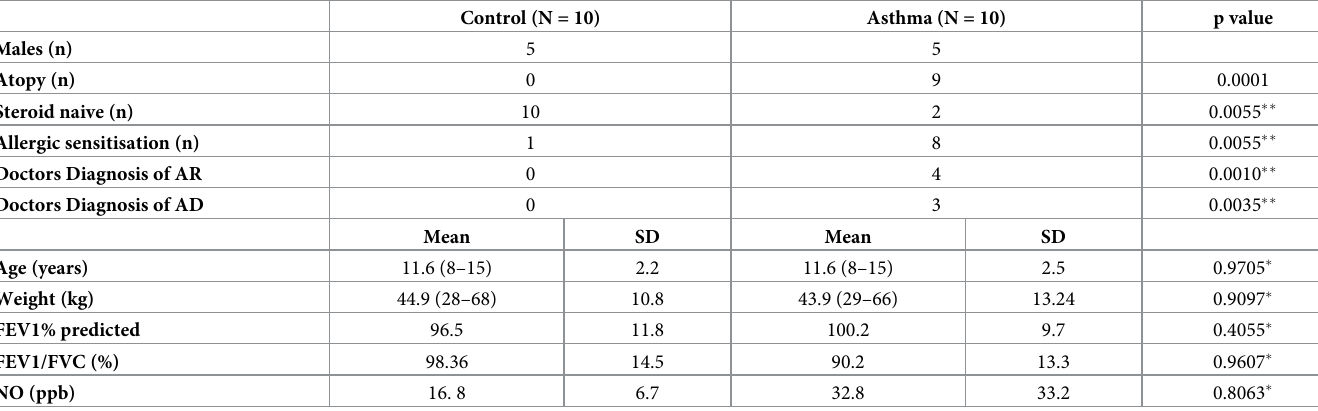
Table 1. Characteristics of the study population.